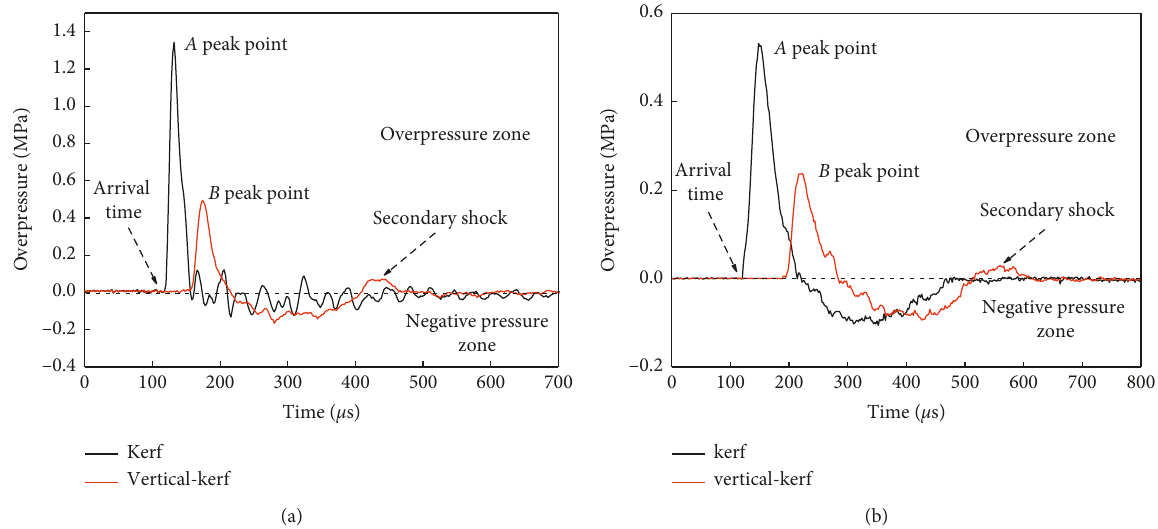
Figure 8: Curve of explosion shock wave overpressure of cutting seam cartridge. (a) 5 cm from the cartridge center. (b) 10cm from the cartridge